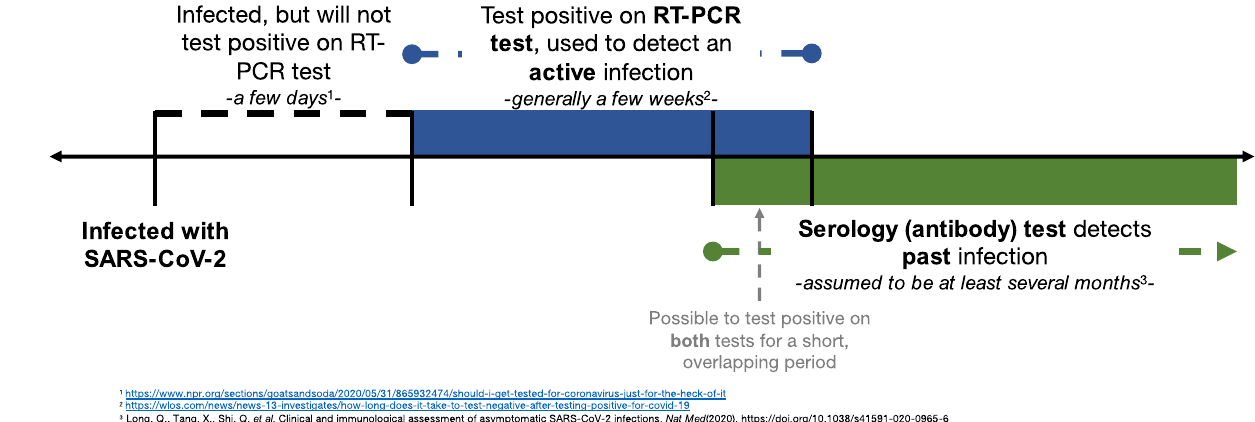
Figure 1. Timeline of COVID-19 diagnostic and antibody testing with respect to the infection and immune response time